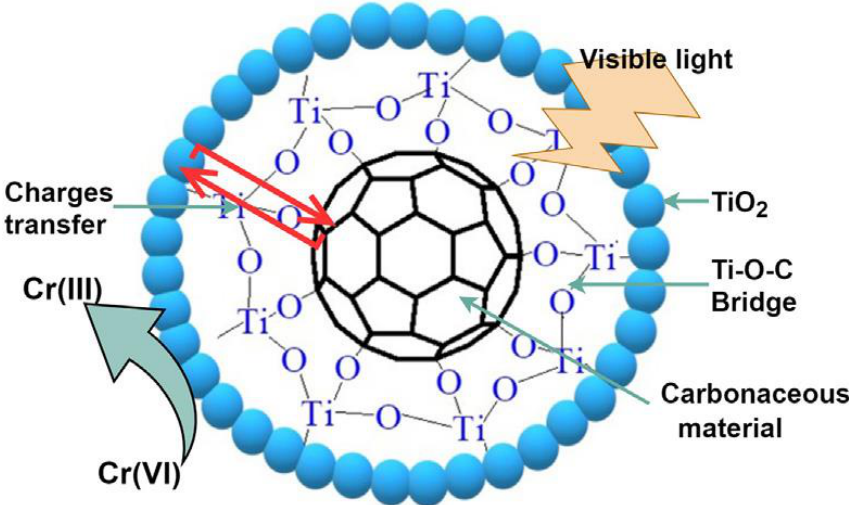
Figure 2. Schematic of proposed degradation of pollutants with TiO 2 / carbon composites. Adapted with permission from Reference [63]. Copyright (2019) Elsevier.